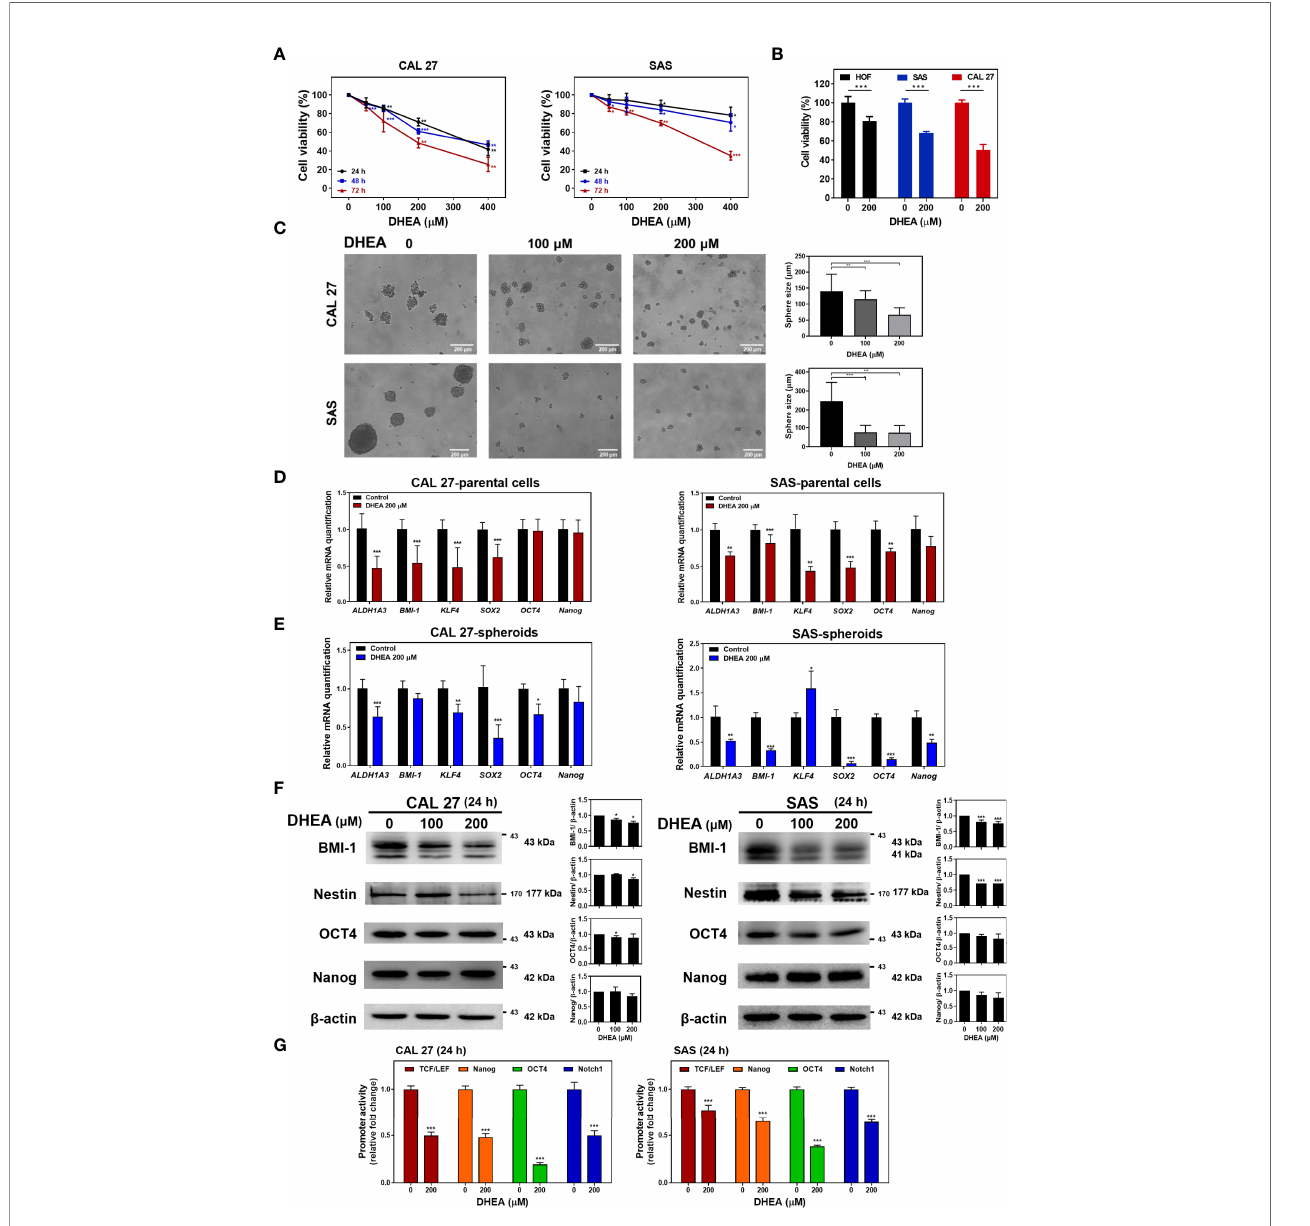
FIGURE 1 | DHEA showed anticancer effect by reducing sphere size, expression of stemness markers, and transcriptional activity of related proteins in HNSCC cells. (A) HNSCC cells were treated with 0, 50, 100, 200, and 400 m M DHEA for 24, 48 and 72 h Cell viability was determined by SRB assay. (B) HNSCC cells and HOF were treated with 0 and 200 m M DHEA for 72 h. Cell viability was determined by SRB assay. (C) Sphere formation assay results showing CAL 27 and SAS cells incubated with 0, 100, and 200 m M DHEA for 20 days. Scale bar: 200 µm (D, E) RT-qPCR results showing mRNA level of stemness markers in CAL 27 and SAS parental cells (D) , and spheroids (E) after treatment with 200 m M DHEA for 6 h (F) Western blot analysis showing expression of stemness marker in CAL 27 and SAS cells after DHEA treatment for 72 h. Left , representative western blots of three independent experiments are shown. Right , bar charts represent the quantitation of three independent experiments. (G) Luciferase reporter assay showing transcriptional activity of stemness-related markers, including TCF/LEF (WNT), Nanog, OCT4, and Notch1 in CAL 27 and SAS cells after treatment with 200 m M DHEA for 24 h. Data represent mean ± standard deviation (SD) derived from three independent experiments. * p < 0.05; ** p < 0.01; *** p < 0.001, compared to control (1% DMSO only) using t-test